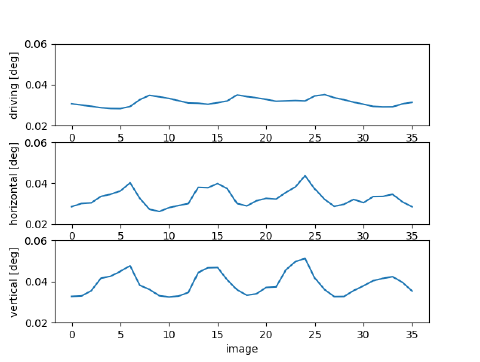
Figure 6. Results of visual localization by using static GCPs in a random tie point cloud.